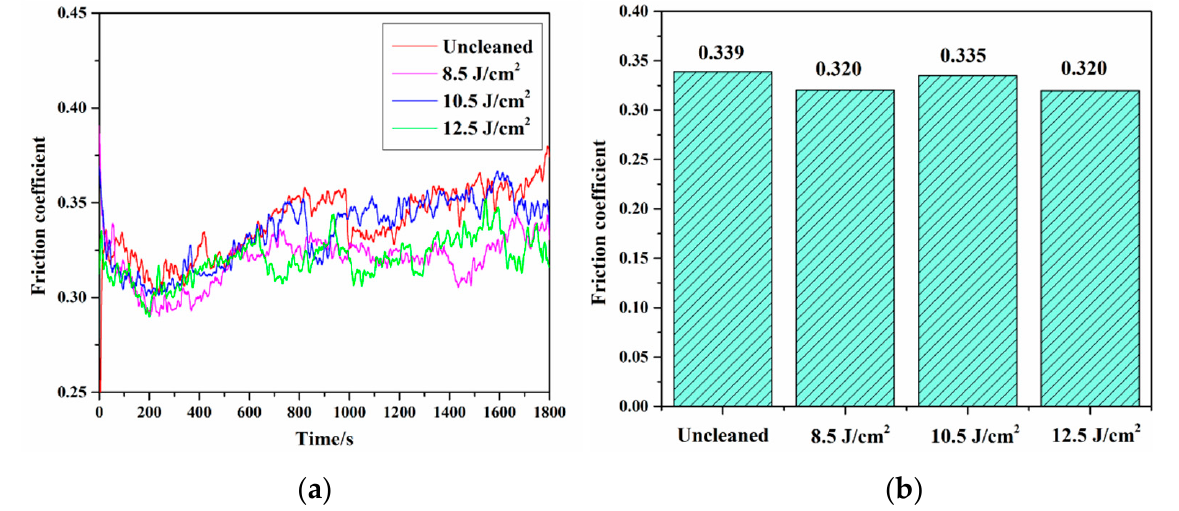
Figure 5. Wear scar morphology of each sample under different loading energy densi- ties: ( a ) not cleaned; ( b ) 8.5 J/cm 2 ; ( c ) 10.5 J/cm 2 ; ( d ) 12.5 J/cm 2 .